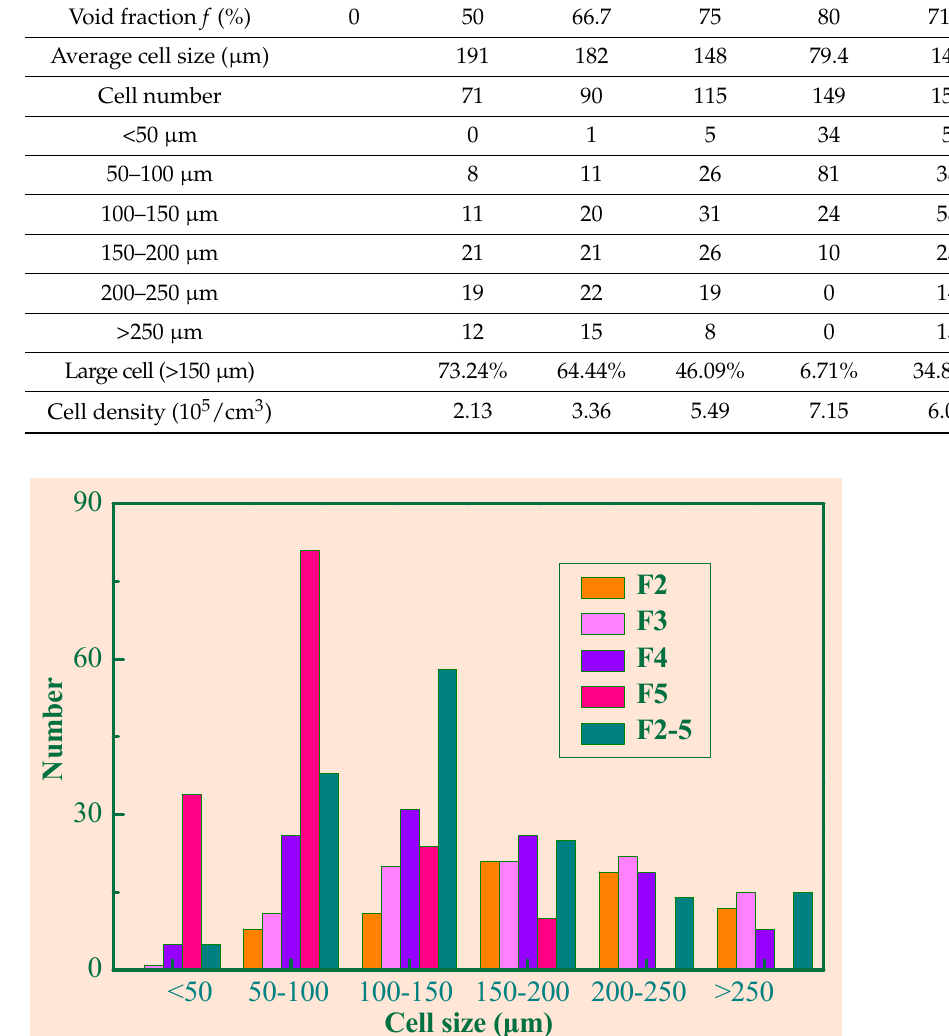
Table 2. Basic properties of SR/Gr (1 wt%) foam materials.